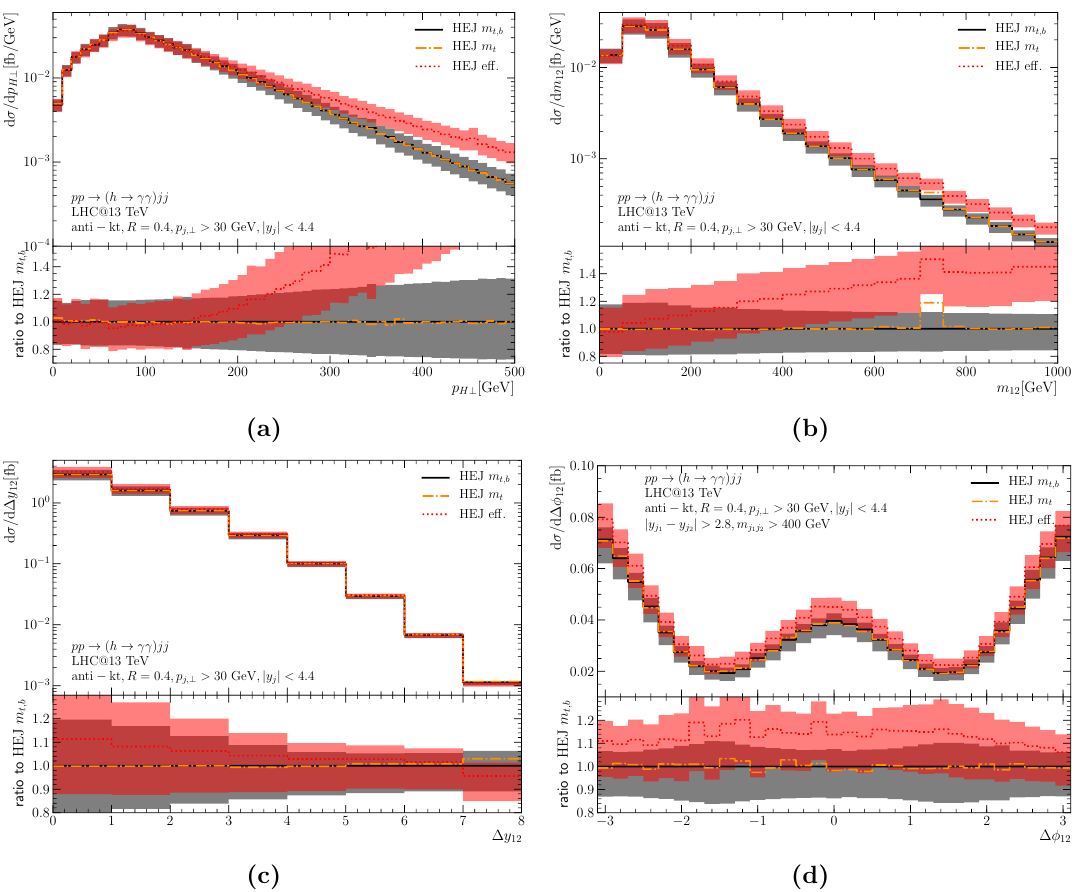
Figure 10 . The result of the all-order matched results of HEJ with three descriptions of the quark masses: in(cid:12)nite top-quark mass (red, dotted), (cid:12)nite m t (orange, dot-dashed), and (cid:12)nite m t and m b (black/grey, solid). See text for further